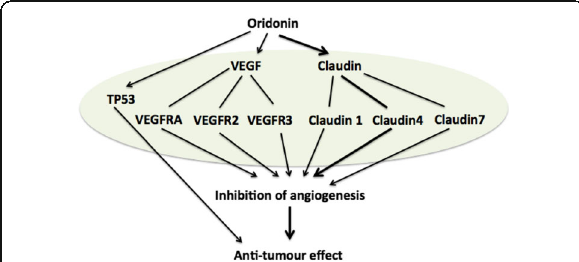
Fig. 16 The different targets and signaling pathways regulated by oridonin. The pictorial summarized mechanism for inhibition of angiogenesis and anti-tumor effect by oridonin. Arrows indicate regulations by oridonin treatment in experimental